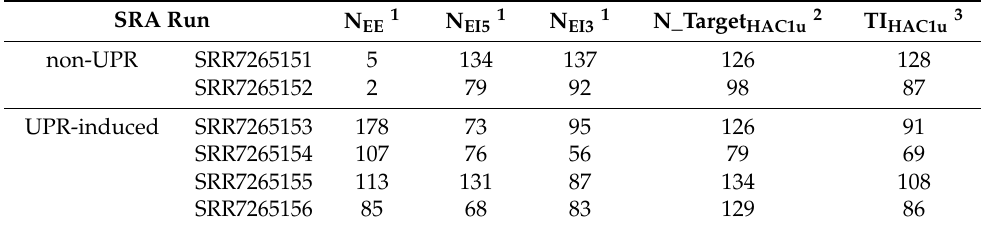
Table 2. Ribosome profiling shows good HAC1 u translation intensity in both cell types. The number of translation units mapped to the spliced HAC1 i transcripts was estimated by N EE , whereas the number of translation units mapped to the unspliced HAC1 u transcripts was estimated by TI HAC1u (the average of N EI5 , N EI3 , and N_Target HAC1u ). Number of ribosome-protected reads mapped to each region was determined by ungapped BLAST in ARSDA. BLAST databases were made from Ribo-Seq datasets of WT yeast cells expressed under non-UPR (SRR7265151, 2), DTT-induced UPR (SRR7265153, 4), and Tm-induced UPR (SRR7265155, 6) conditions. SRA Run N EE 1 N EI5 1 N EI3 1 N_Target HAC1u 2 TI HAC1u 3 non-UPR